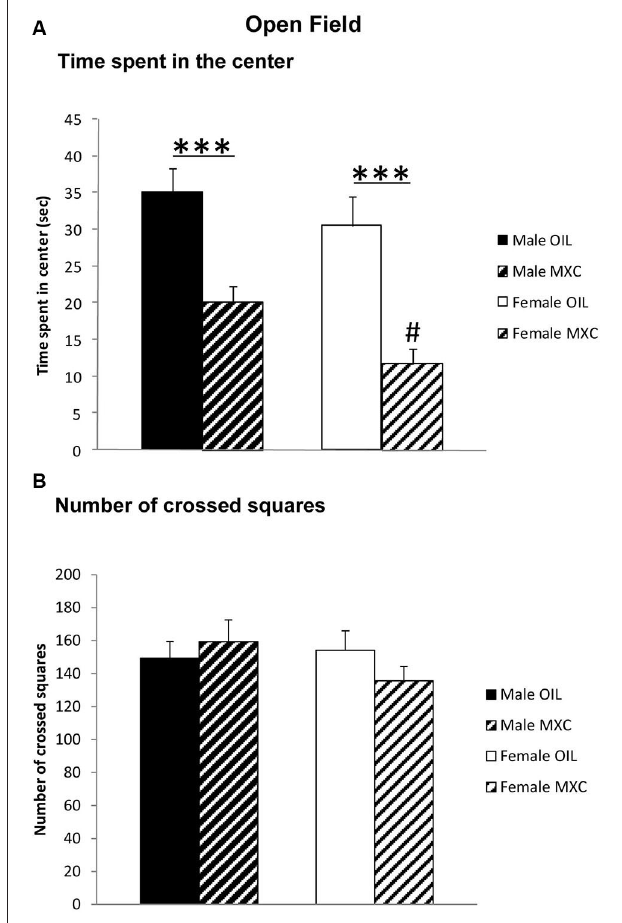
FIGURE 2 | (A) Time spent in the central area and (B) total number of crossed squares in an open field. Perinatal MXC exposure induced a decrease in the time spent in the central area in female compared to male mice and a significantly decrease in MXC treated mice compared to control mice. No differences of the total number of crossed squares were detected, as indicator of locomotor activity. Data are expressed as mean ± SEM. *** p < 0.001; # p < 0.05 males vs.